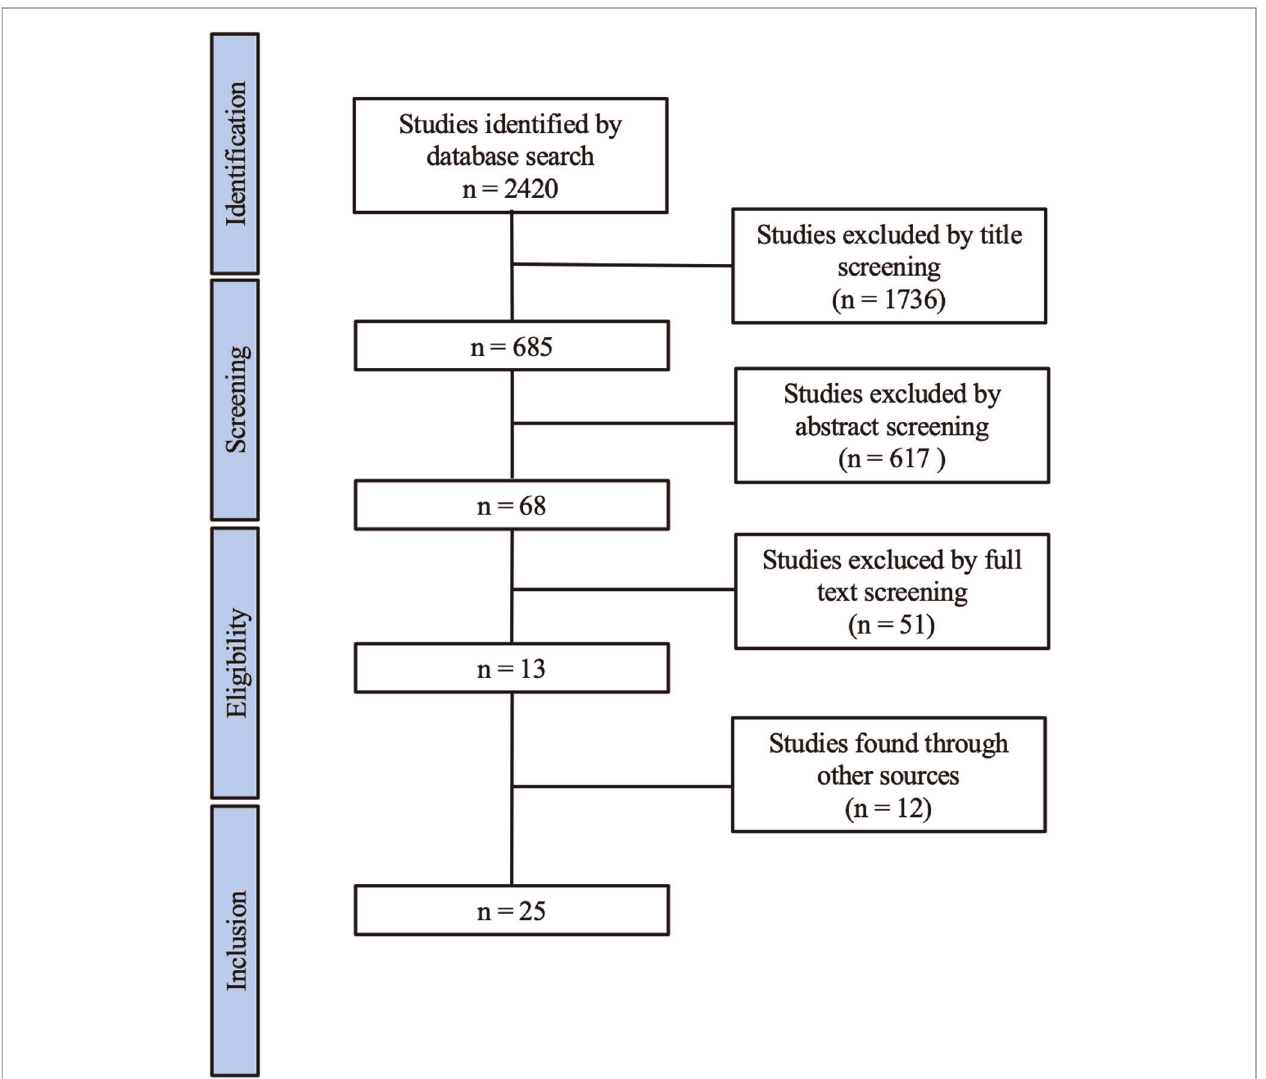
FIGURE 1 | Preferred Reporting Items for Systematic Reviews and Meta-Analysis fl ow diagram of the study identi fi cation and selection process